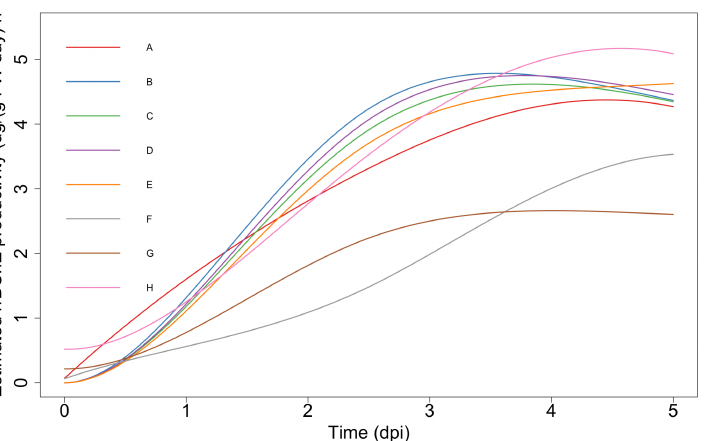
Figure 5. Estimated “unweighted” productivity curves based on observed data. Note that T ( c ) = ( 6,6,6,7,6,8,14,8 )